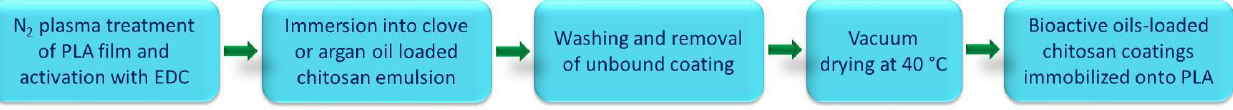
Scheme 1. The flow chart showing the preparation of PLA films bio-functionalized with oil-containing coatings.